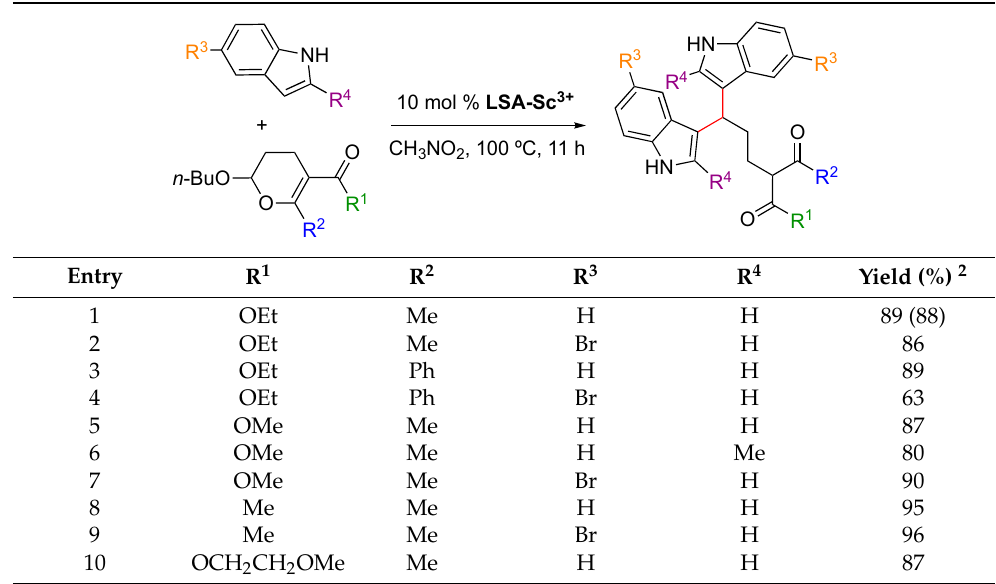
Table 3. LSA-Sc 3+ catalyzed electrophilic ring-opening reactions of 2-butoxy-3,4-dihydropyrans with indoles [33] 1 .